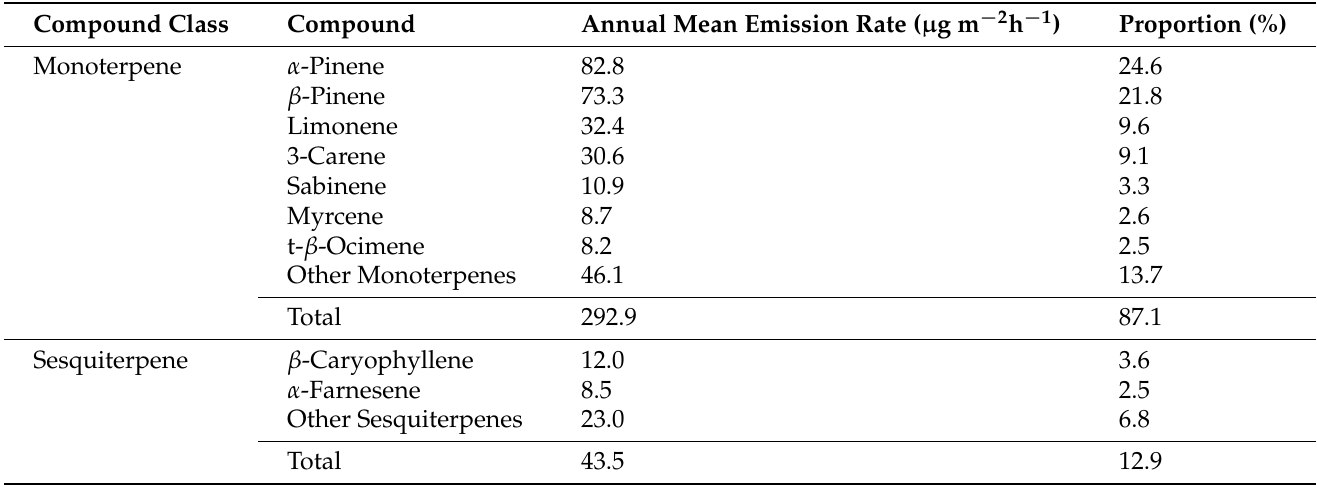
Table 4. Annual mean emission rate (µgm − 2 h − 1 ) of each terpene in Saneum-ri area.